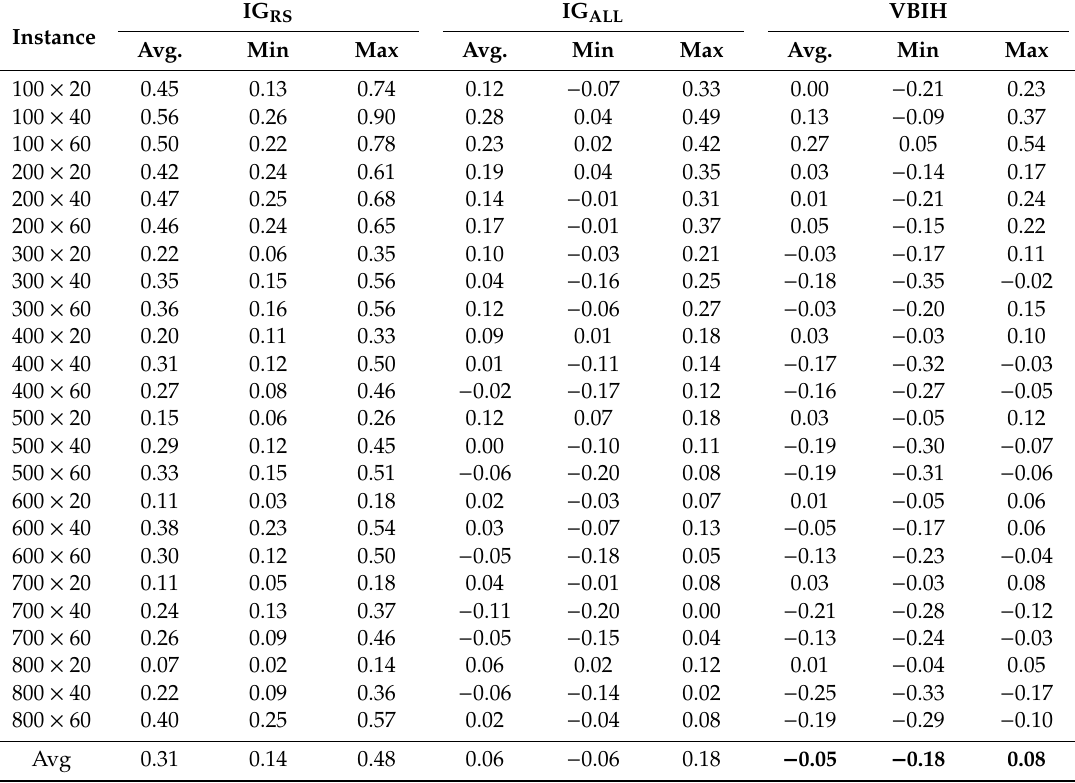
Table 6. Computational results of algorithms with 𝑇 (cid:3040)(cid:3028)(cid:3051) = 15 × 𝑛 × 𝑚 milliseconds (The bolds show better results).